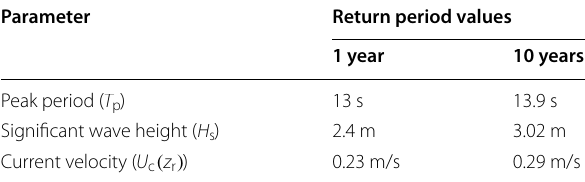
Table 4 Wave and current design